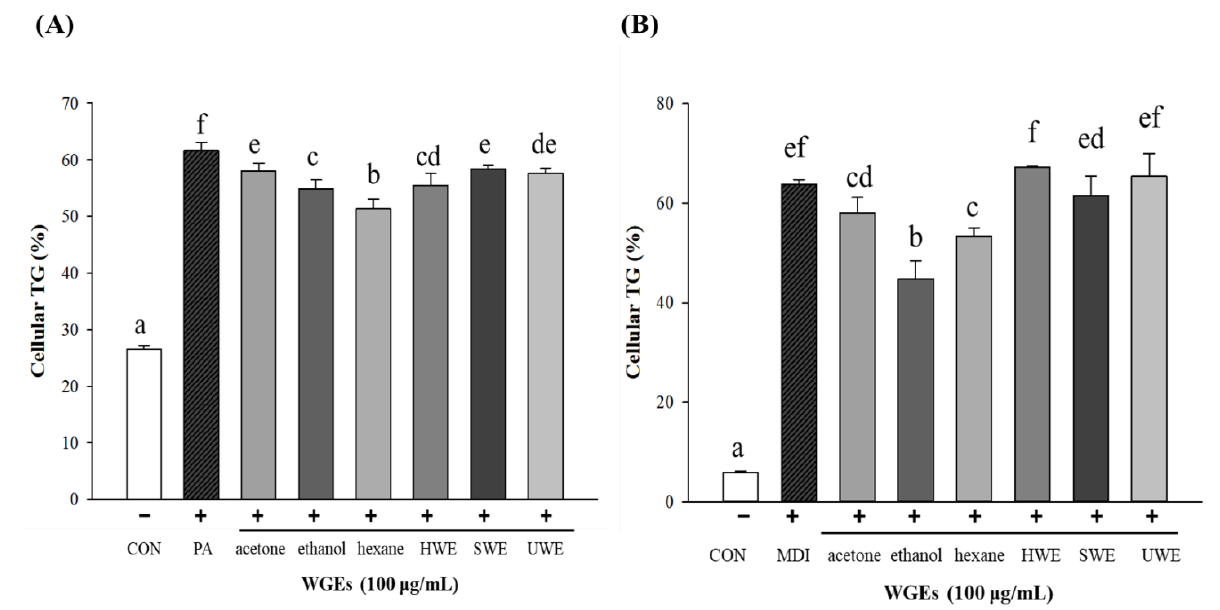
Figure 6. Effect of wheat germ extracts (WGEs) on cellular triglyceride (TG) accumulation. ( A ) The cellular TG accumulation in hepatocytes. ( B ) The cellular TG accumulation in differentiated adipocytes. TG concentration was normalized with protein content. Different letters indicate significant differences at p < 0.05 determined by Duncan’s multiple range test. CON, control; PA, palmitic acid; MDI (methylisobutylxanthine, dexamethasone, insulin; differentiated media); HWE, hot water extract; SWE, subcritical water extract; UWE, ultrasonic water extract.